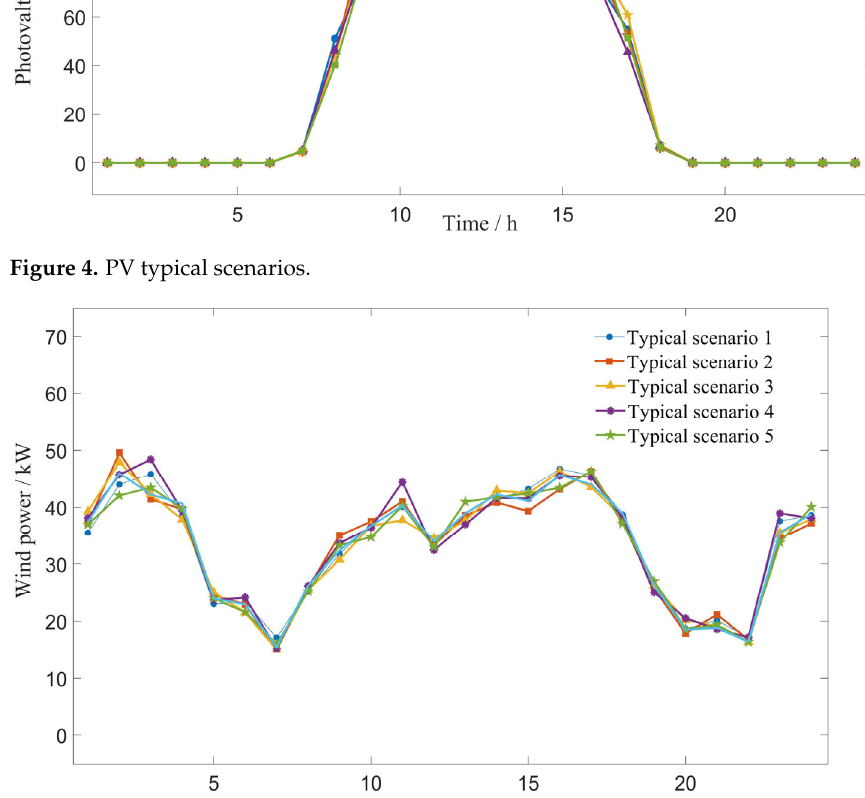
Figure 5. Wind typical scenarios.